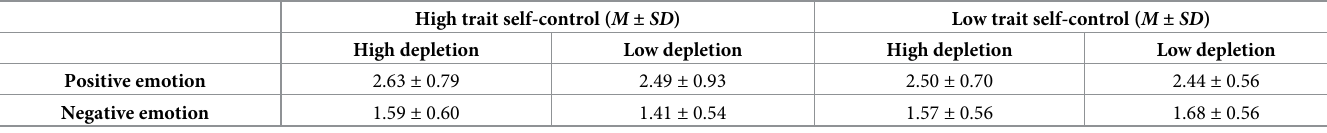
Table 5. Descriptive statistics of scores in positive and negative emotional